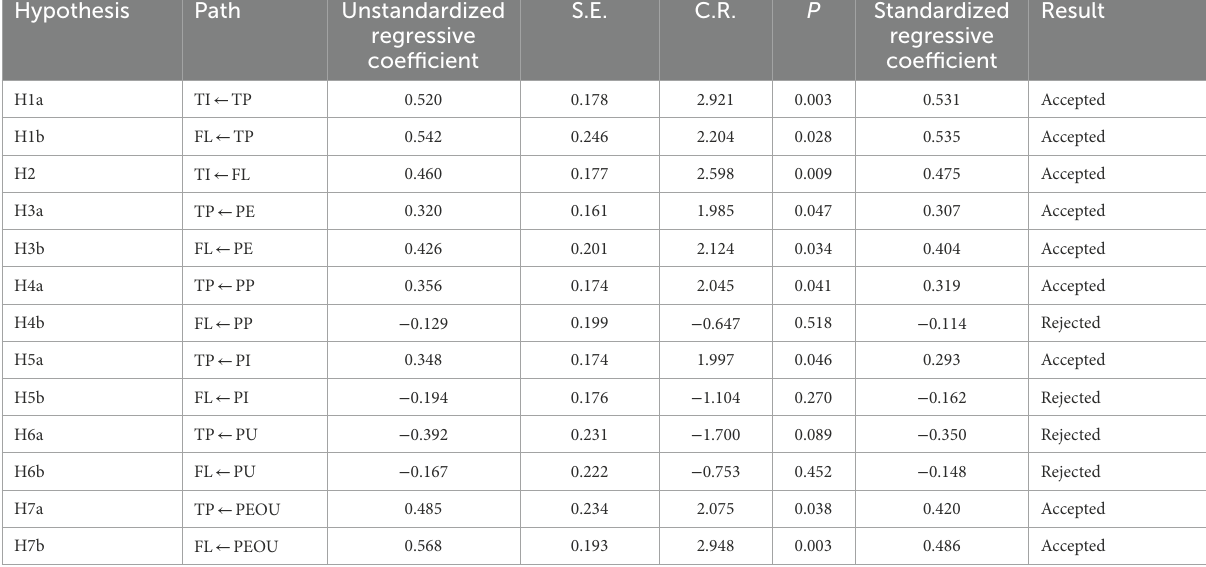
TABLE 5 Analysis of model